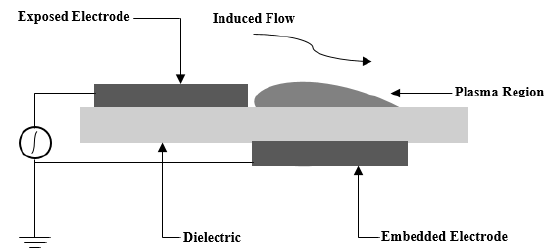
Figure 4. Schematic of dielectric barrier discharge (DBD)